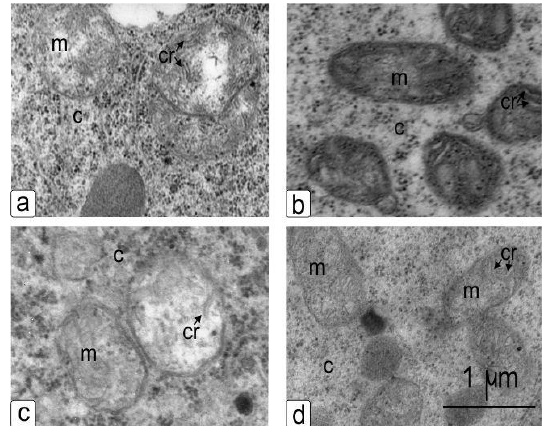
Figure 7. Mitochondria in the young cells of the cortex of the main root of wheat during germination Figure 7.